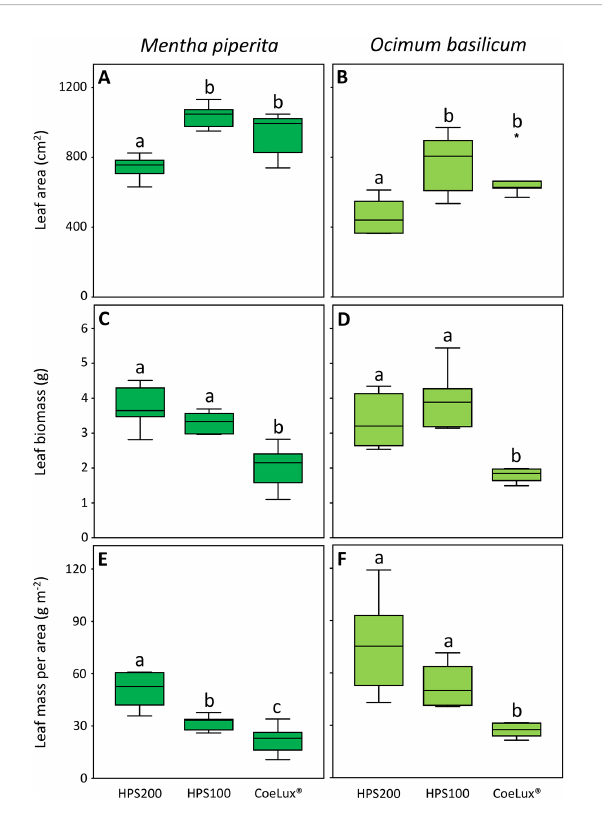
FIGURE 5 (A, B) shoot and root biomass (g), (C, D) shoot-to-root ratio, and (E, F) lamina-to-petiole length ratio measured under different light treatments for Mentha piperita (dark green) and Ocimum basilicum (light green) plants. Box plots represent n=6 biological repeats while letters represent statistically signi fi cant differences (p< 0.05). Vertical boxes represent approximately 50% of the observations and lines extending from each box are the upper and lower 25% of the distribution. Within each box, the solid horizontal line is the median value. Circles and asterisks represent respectively outliers and extreme